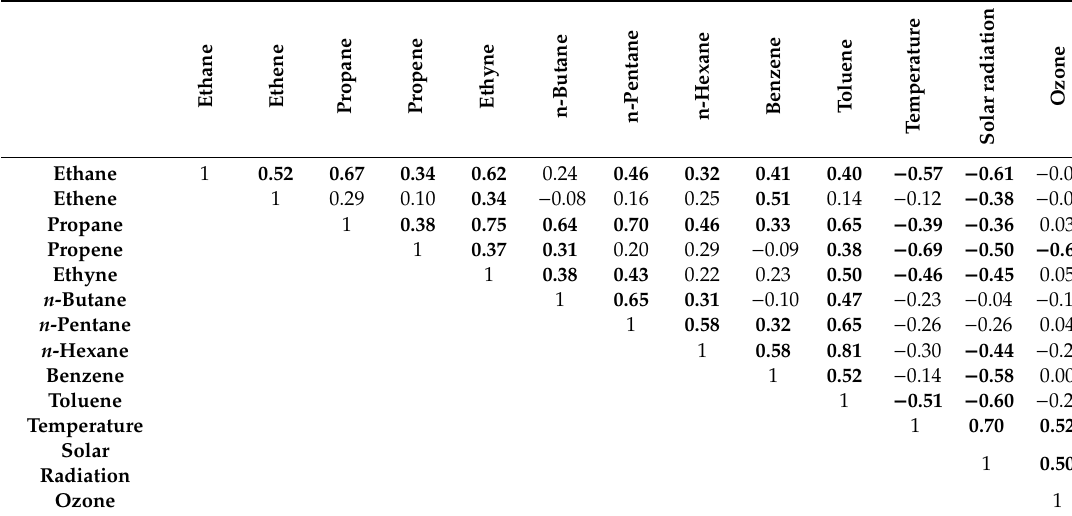
Table 2. Spearman’s rank correlation coe ffi cients of hourly average concentrations of hydrocarbons, ozone and meteorological parameters measured at Mali Lošinj (bold marked correlations are significant at p <